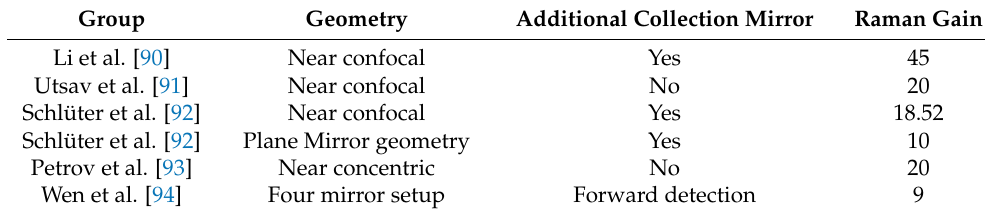
Table 3. Raman gains of non-resonant multi-pass